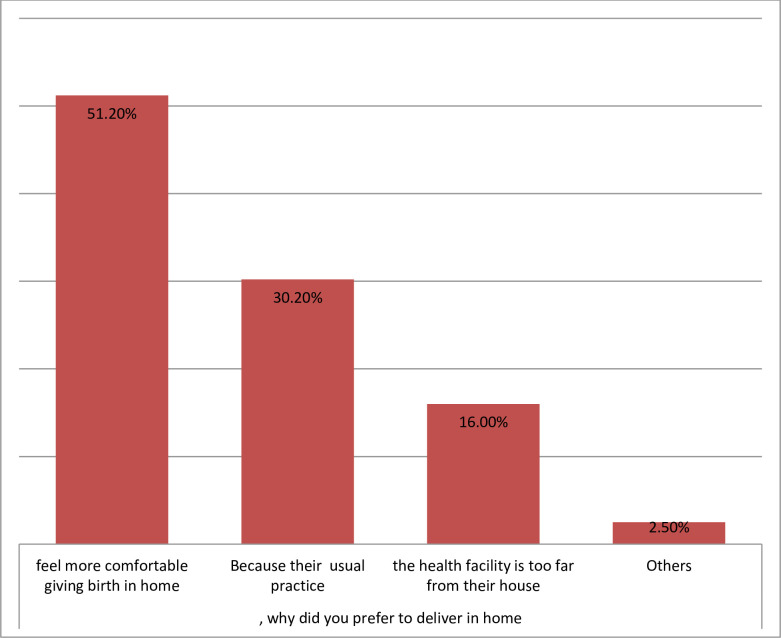
Reasons of women gave birth in home among study subjects in Mandura district, 2019.